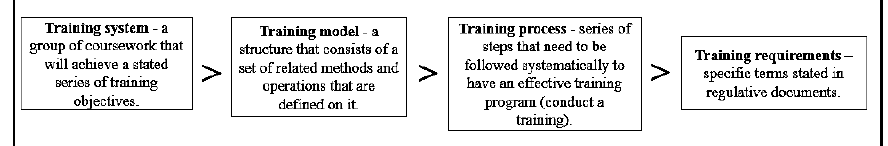
Fig. 1. Conceptual relation. Source: